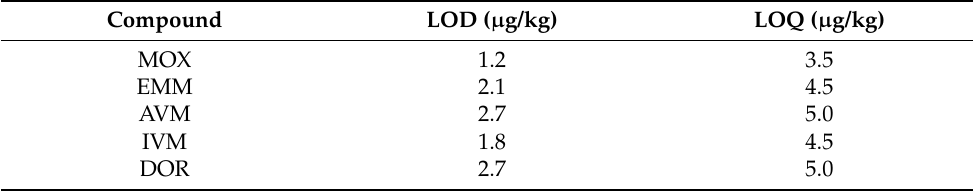
Table 4. LODs and LOQs of five AVMs in matrix matching standard solutions.